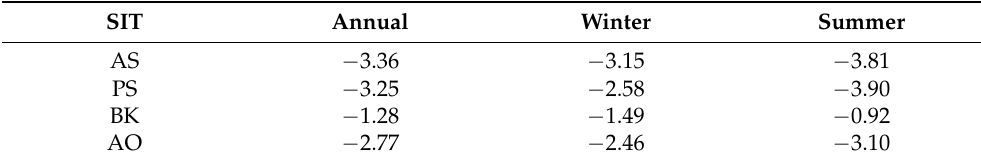
Table 3. The annual and seasonal variability trends of SIT (10 − 2 m) in 1979–2020 for the Atlantic sector, Pacific sector, Barents–Kara Seas and the Arctic Ocean.